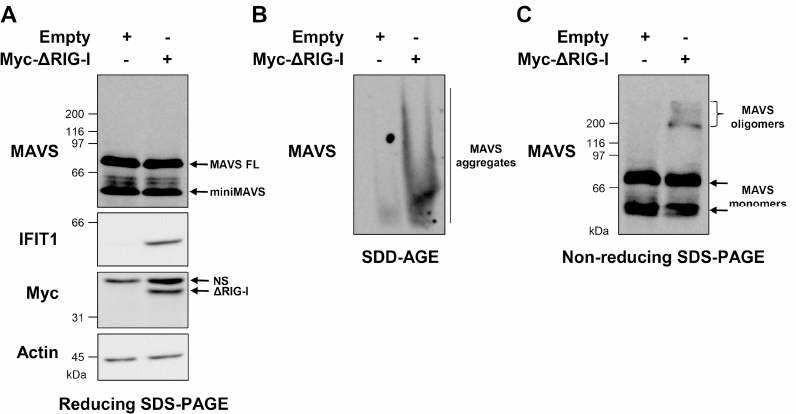
Figure 2. Activation of retinoic acid-inducible gene I (RIG-I) is sufficient to induce MAVS aggregation and oligomerization. A549 cells were transfected for 24 h with a plasmid encoding constitutively active RIG-I (Myc- Δ RIG-I) or an empty vector. The WCEs were prepared immediately after harvesting. WCEs were resolved by SDS-PAGE in reducing ( A ) or non-reducing ( C ) conditions followed by immunoblot analysis using anti-MAVS, anti-IFIT1, anti-Myc and anti-actin antibodies. In ( B ), WCEs were analyzed by SDD-AGE coupled to anti-MAVS immunoblot. NS: non-specific. 3.3. Ectopically Expressed MAVS Is Detected as Oligomeric and Aggregated States